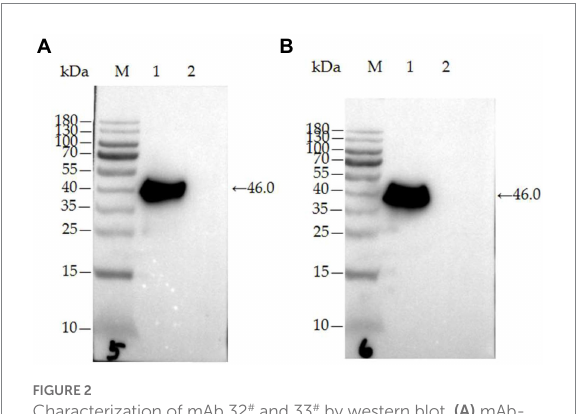
FIGURE 2 Characterization of mAb 32 # and 33 # by western blot. (A) mAb-